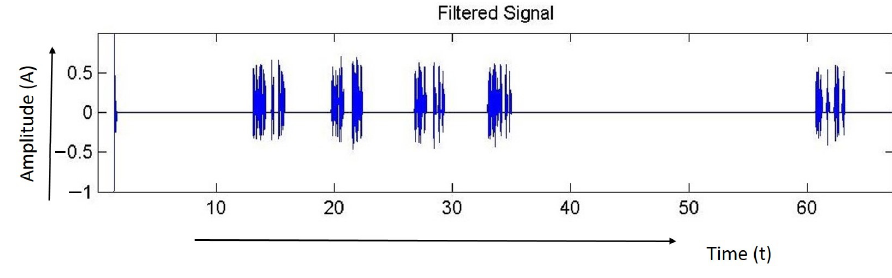
Figure 5. De-noised (Event)